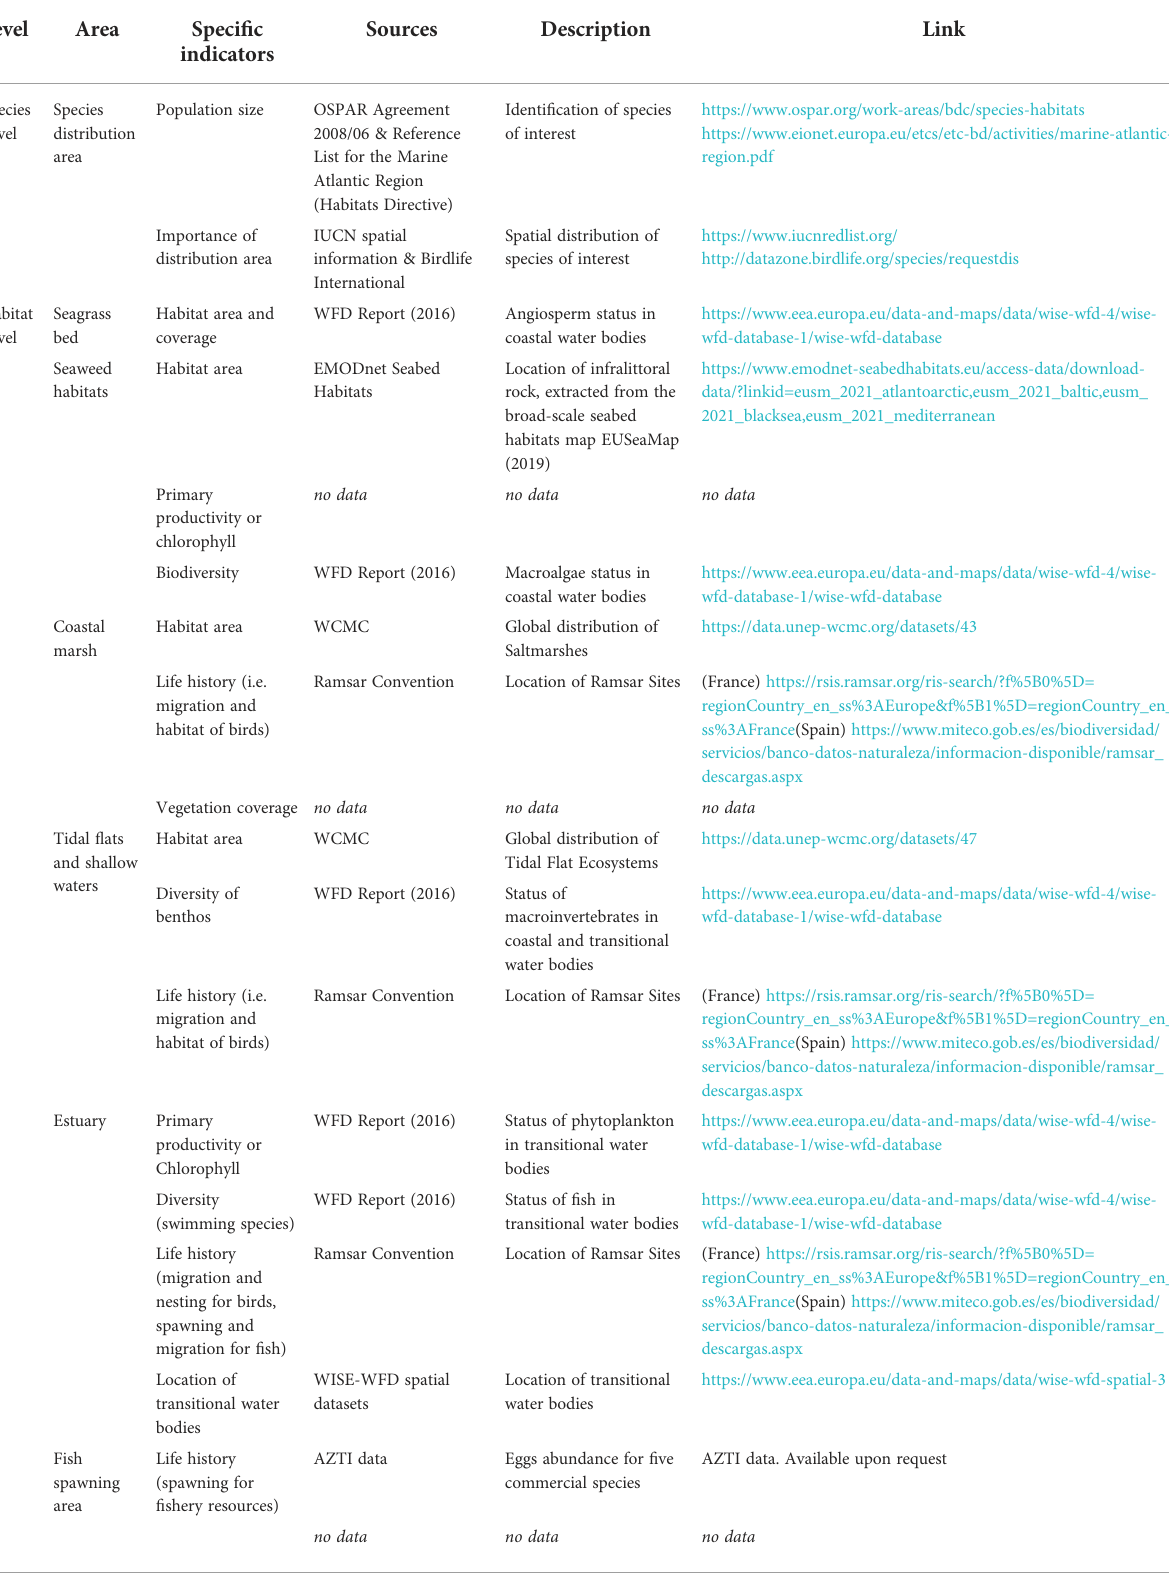
TABLE 1 Evaluation of areas of ecological importance at species and habitats levels, as described in the Marine Resource-Environment Carrying Capacity (MRECC)